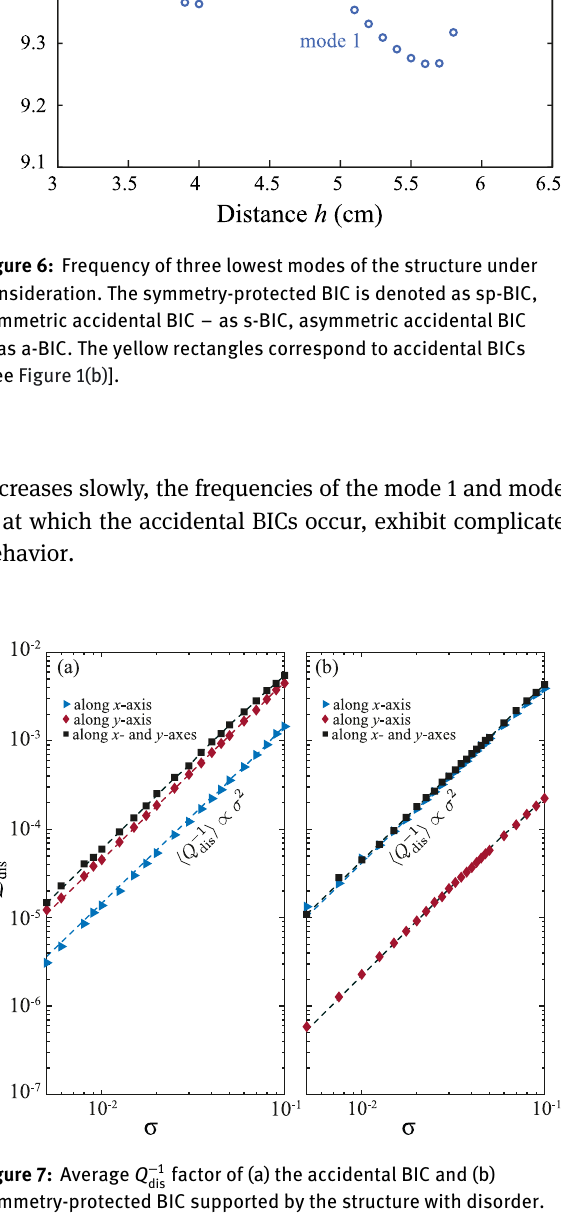
factor of (a) the accidental BIC and (b) Figure 7: Average Q − 1 dis symmetry-protected BIC supported by the structure with disorder. Dashed lines show quadratic